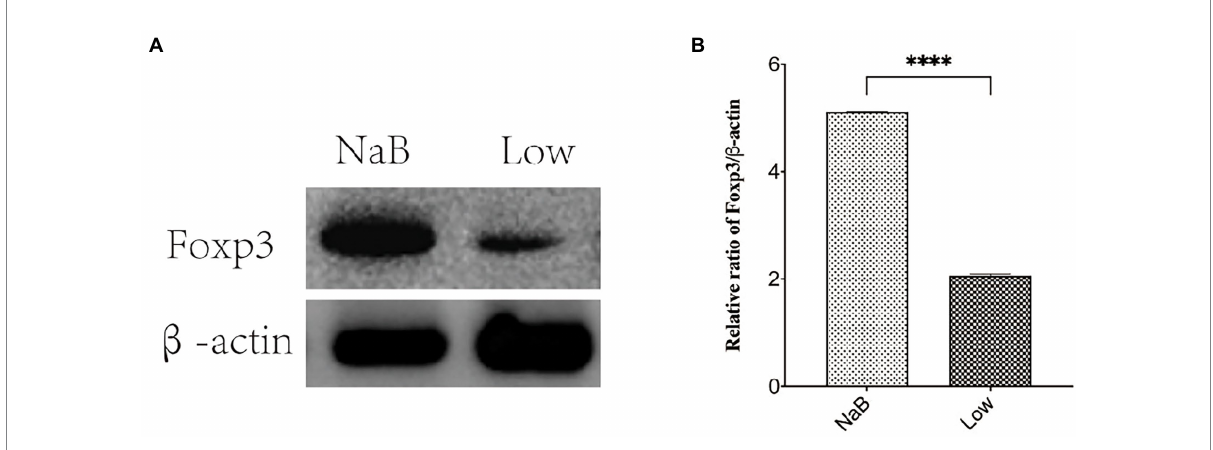
FIGURE 14 The protein expression of Foxp3 was detected by western blotting. (A) Protein banding. (B) Histogram. **** p <